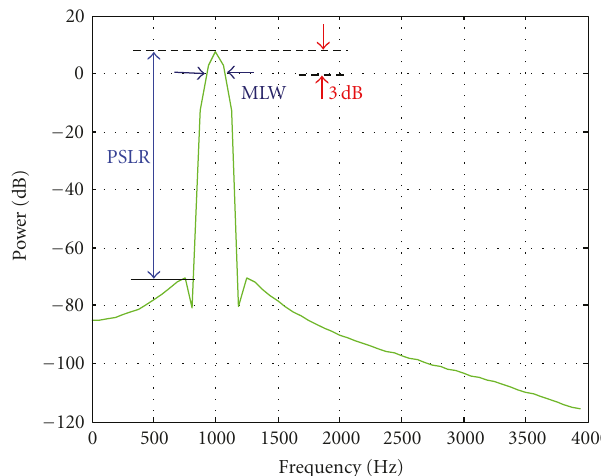
Figure 3: Performance measures used in the analysis, MLW and PSLR.